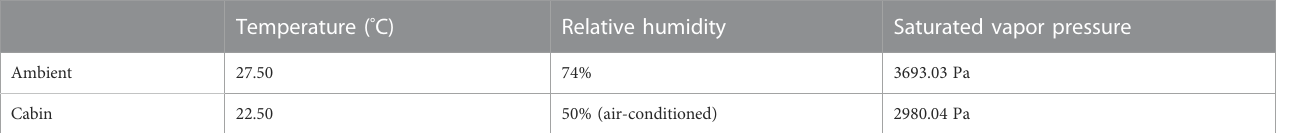
TABLE 3 Relative humidity (RH) and saturated vapor pressures at given temperatures.